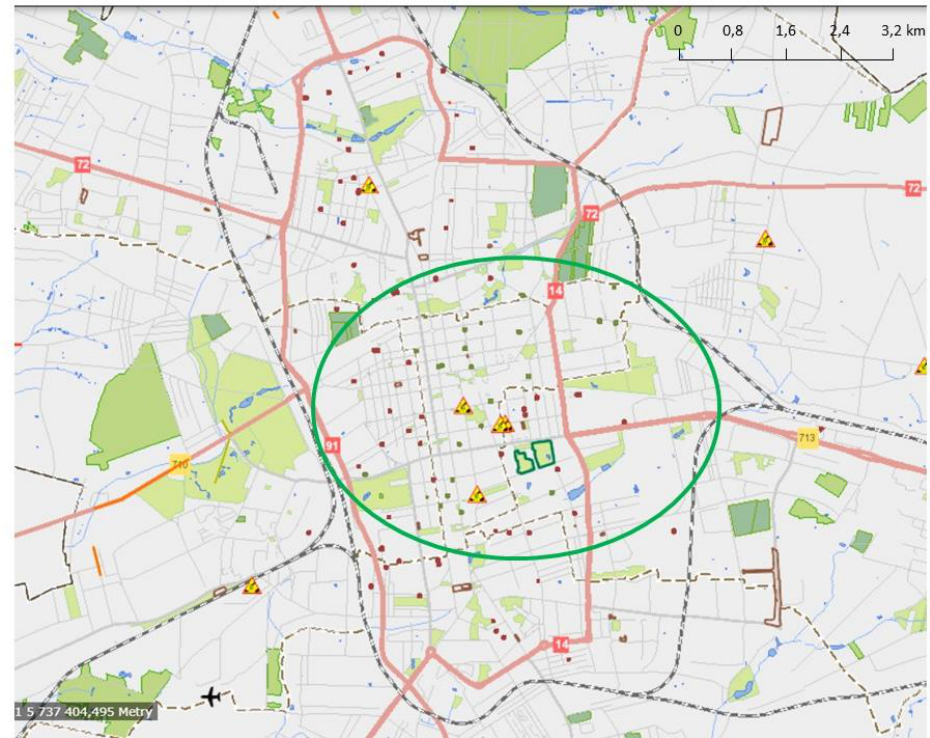
Fig. 8. Developer investments identified inside the Agglomeration Railway: in Śródmieście (green) and outside it (red) at the end of 2021 (Source: Own elaboration based on InterSIT map of Municipal Geodesy Centre of Łódź and real estate